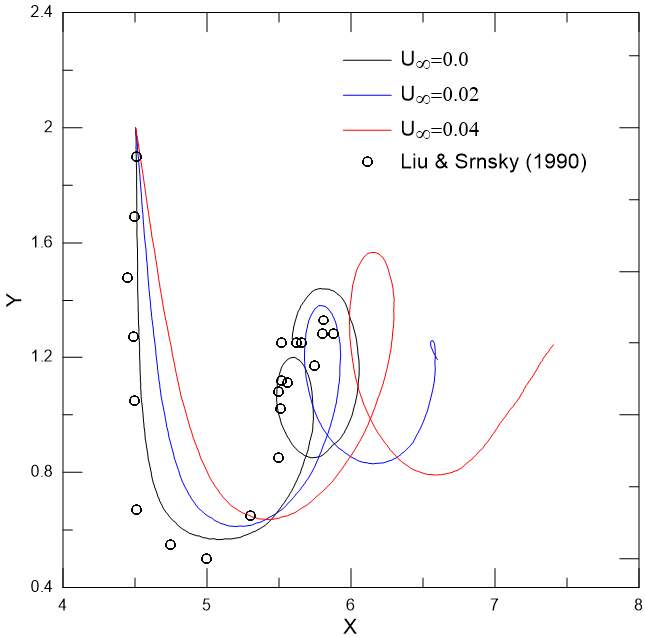
Figure 10. Influence of combined effects of buoyancy and crosswind on the predicted trajectories for the right-side vortical structure from the wing tip (Ri = 1.018, T ∞ * = 20 ◦ C, T W * = 40 ◦ C, Pr = 0.7, and Re = 7650) [9].